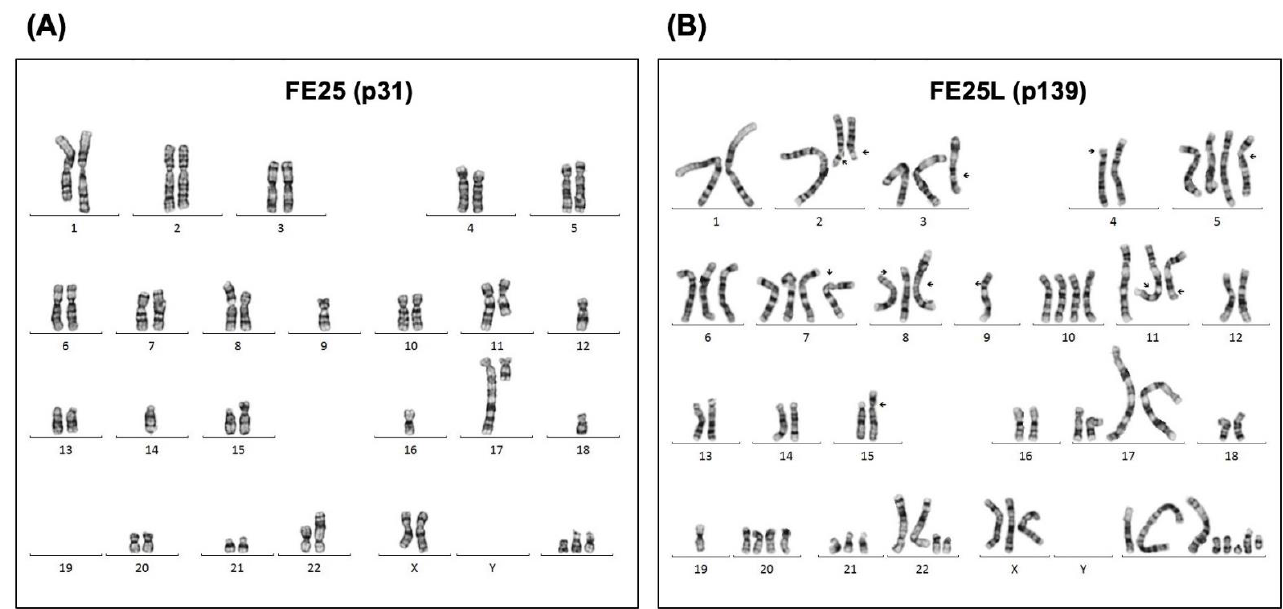
Figure 4. FE25L cells (p122) generate more tumors than FE25 cells (p19) in a xenograft model. NSG female mice (4 – 5 weeks of age) were subcutaneously injected with 1 × 10 6 FE25 or FE25L cells ( n = 3 in each group). ( A ) Tumor growth curve. Tumors appeared after 165 and 176 days in FE25L and FE25, respectively. All three mice injected with FE25L resulted in tumors (3/3) whereas only 1 mouse showed tumor in the FE25 injected group (1/3). ( B ) Gross xenograft tumor morphology of FE25 and FE25L in wax blocks. ( C ) H & E staining of the xenografts obtained from FE25 and FE25L injected mice. Scale bar = 100 μm. ( D ) Immunohistochemistry for fallopian tube epithelium marker, PAX8, WT1, and CK7 for FE25 and FE25L tumors. Scale bar = 100 μm. ( E ) The comparison of WT1 expression between FE25 and FE25L ( n = 3 in each group). *** p < 0.001.